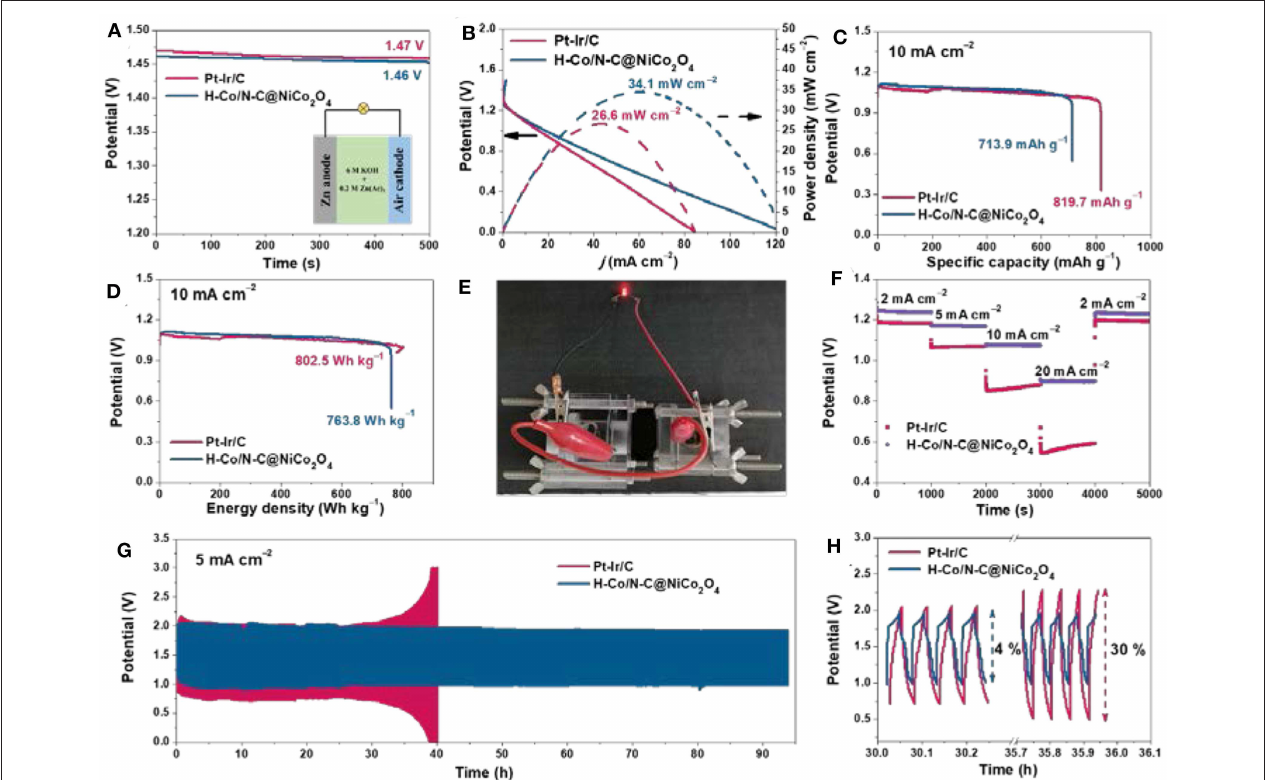
FIGURE 4 | (A) Open-circuit plots (inset picture is the schematic representation of Zn–air battery), (B) polarization curves and corresponding power density plots of the Zn–air battery based on H-Co/N-C@NiCo 2 O 4 and Pt-Ir/C. The calculated (C) specific capacity and (D) energy density of the Zn–air battery based on H-Co/N-C@NiCo 2 O 4 and Pt-Ir/C. (E) Photograph of a red LED powered by two Zn–air battery based on H-Co/N-C@NiCo 2 O 4 in series. (F) Galvanostatic discharge curves, (G,H) galvanostatic discharge–charge cycling curves of Zn–air battery based on H-Co/N-C@NiCo 2 O 4 and Pt-Ir/C.